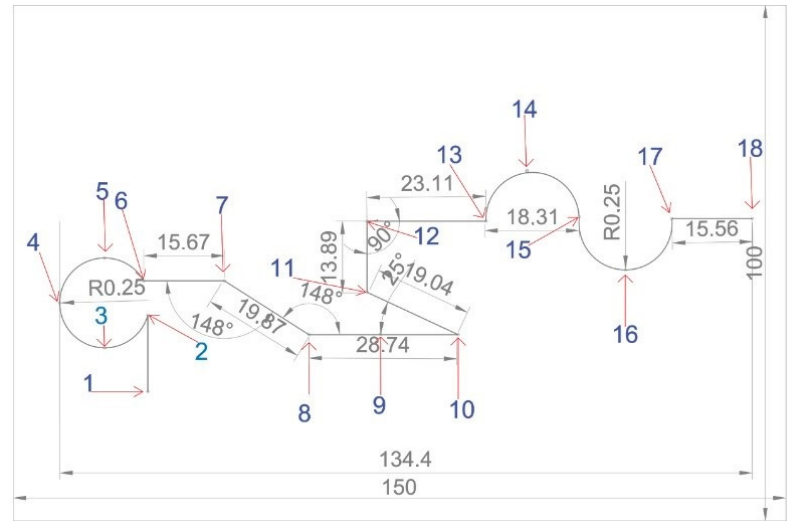
Figure 2. The cutting path design used for specimens with PAC dimensions of 100 × 150 × 1 mm. The hardness test points are indicated as numbers 1 to 18.